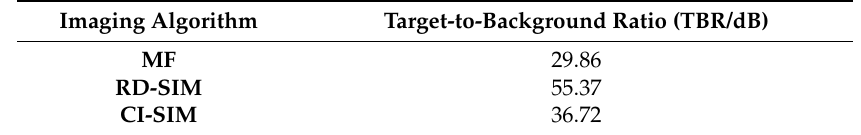
Table 3. Target-to-background ratio (TBR) of target area via different algorithms with multichannel data.